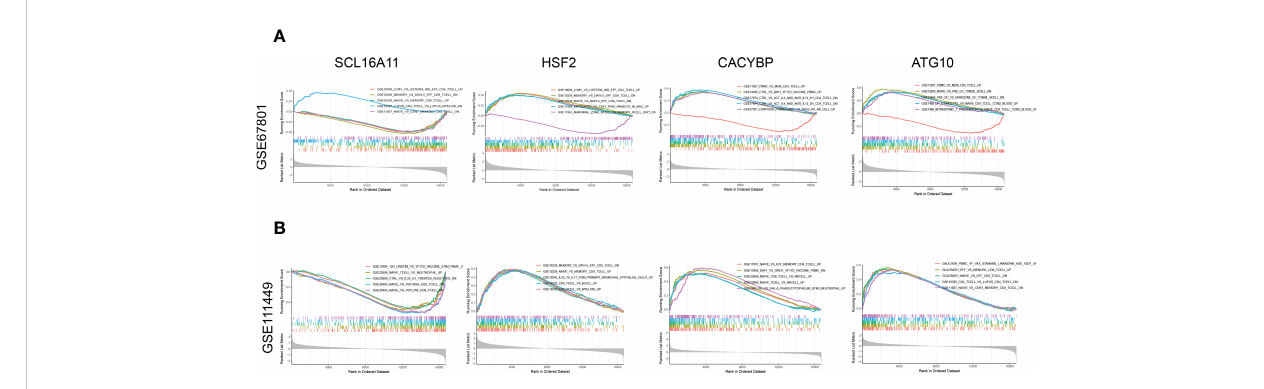
FIGURE 10 GSEA enrichment analysis for Tex-related HCC prognostic genes. (A) Enrichment analysis of immune-related data sets for SLC16A11, CACYBP, HSF2, and ATG10 based on the GSE67801 pro fi le. (B) Enrichment analysis of immune-related data sets for SLC16A11, CACYBP, HSF2, and ATG10 based on the GSE111449 pro fi